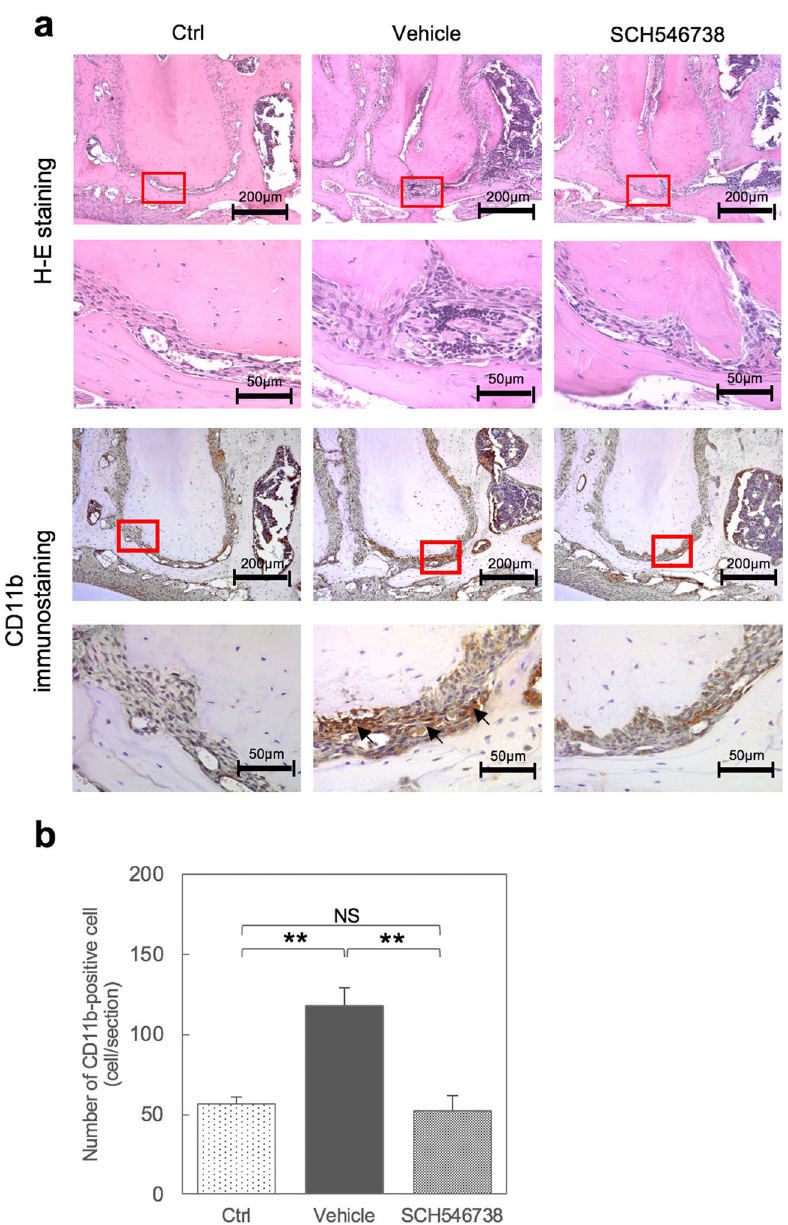
Figure 4. A CXCR3 antagonist reduces CD11b inflammatory cell infiltration in the mouse AP model. ( a ) HE staining and immunostaining of CD11b-positive inflammatory cells (arrows) at 28 days after pulp exposure to SCH546738, vehicle or control with a lower magnification (upper panel) and higher magnification (lower panel) of the square area shown. ( b ) Quantitative analysis of CD11b-stained cells demonstrated significant immune cell infiltration in the vehicle sample compared with the control and SCH543738 treatment groups. Data are expressed as a mean ± S.D; * p < 0.05 compared with the control